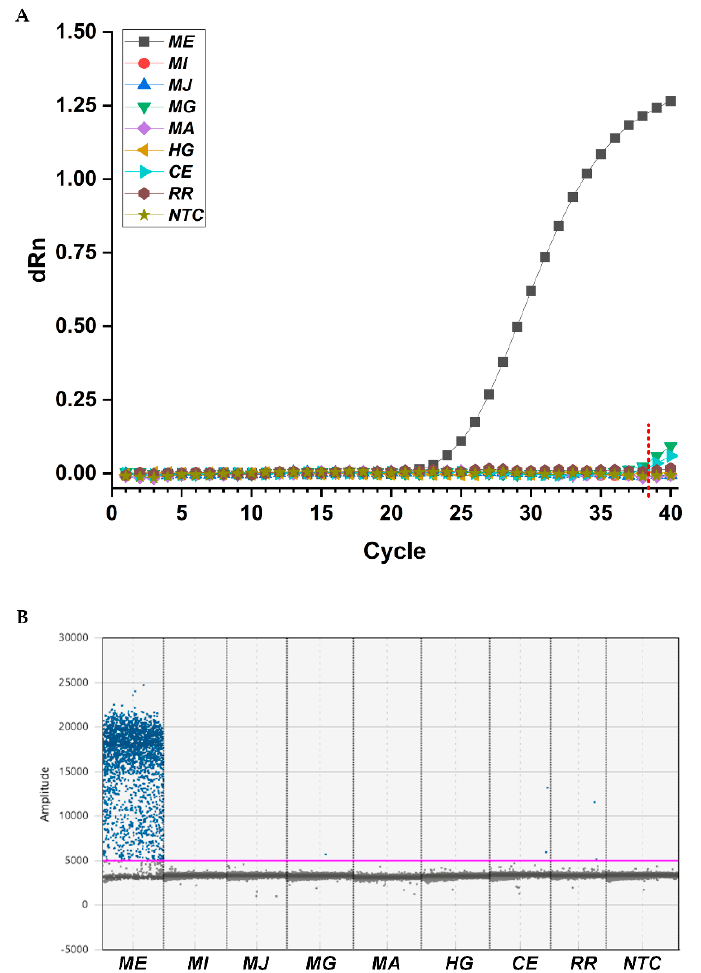
Figure 3. Specificity tests for primers/Taqman probe set analyzed by qPCR ( A ) and ddPCR ( B ) to identify M. enterolobii . ME, M. enterolobii . MI, M. incognita ; MJ, M. javanica ; MG, M. graminicola ; MA, M. arenaria ; HG, H. glycines ; CE, C. elegans ; RR, R. reniformis ; NTC, no template control. dRn, nor- malized fluorescence. The red dashed line indicates the cutoff point in qPCR. The pink line repre- sents the horizontal threshold value of 5000 in ddPCR.